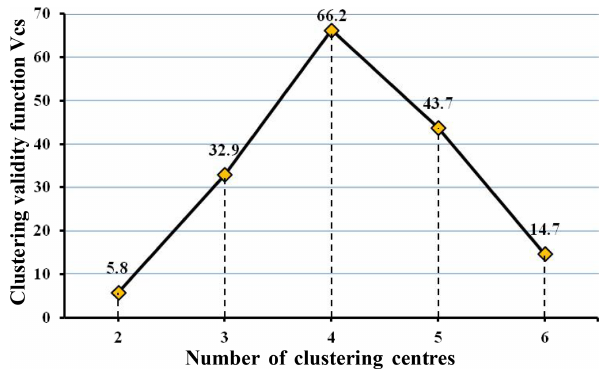
Figure 9. Clustering validity function V cs . Table 5. Clustering results of 21 debris flow